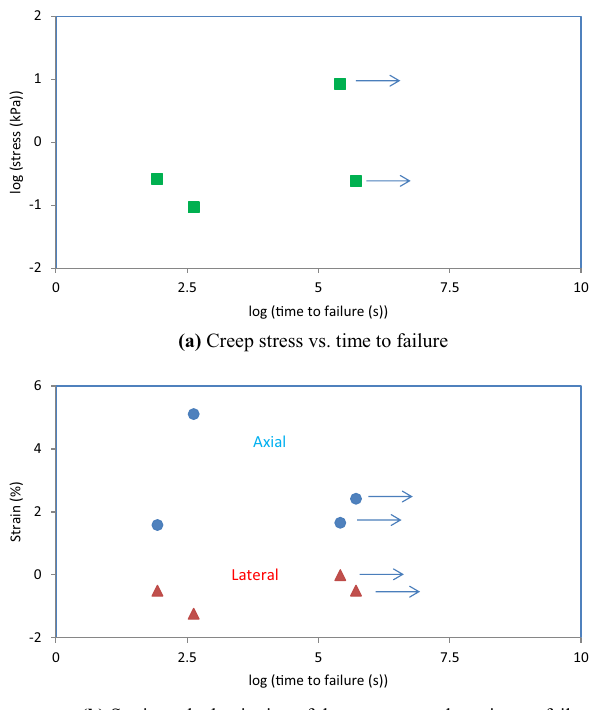
Fig. 12 Time to failure in the uniaxial creep test. The arrows denote that the specimens did not fail